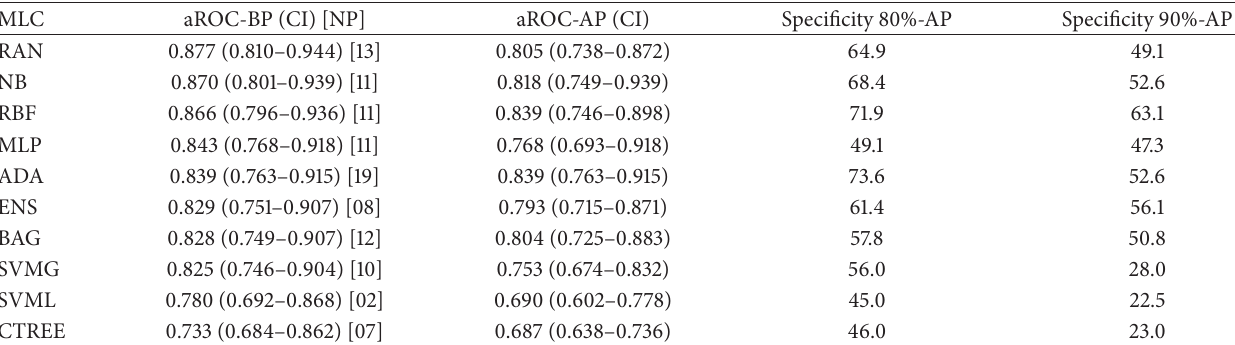
Table 4: Areas under the receiver operating characteristic curve (aROCs) of best parameter (BP) and all 23 parameters (AP) obtained with machine learning classifiers and sensitivities (%) with fixed specificities of 80% and 90% for